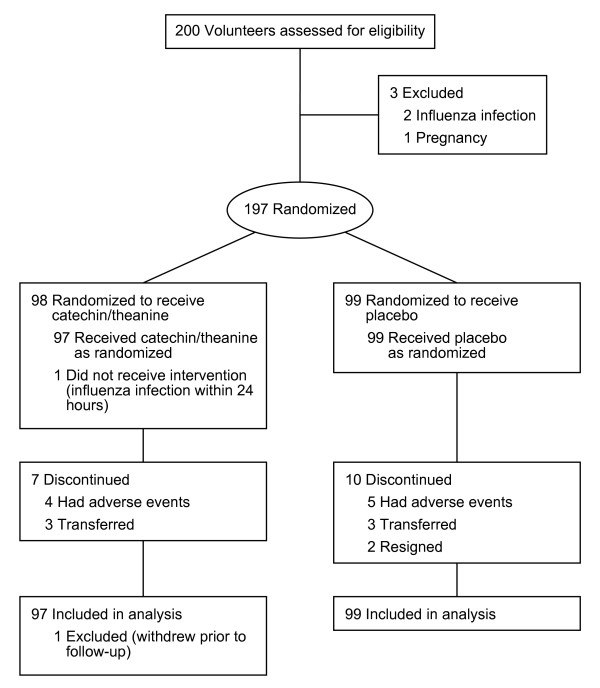
Flow diagram for trial of catechin/theanine vs. placebo.